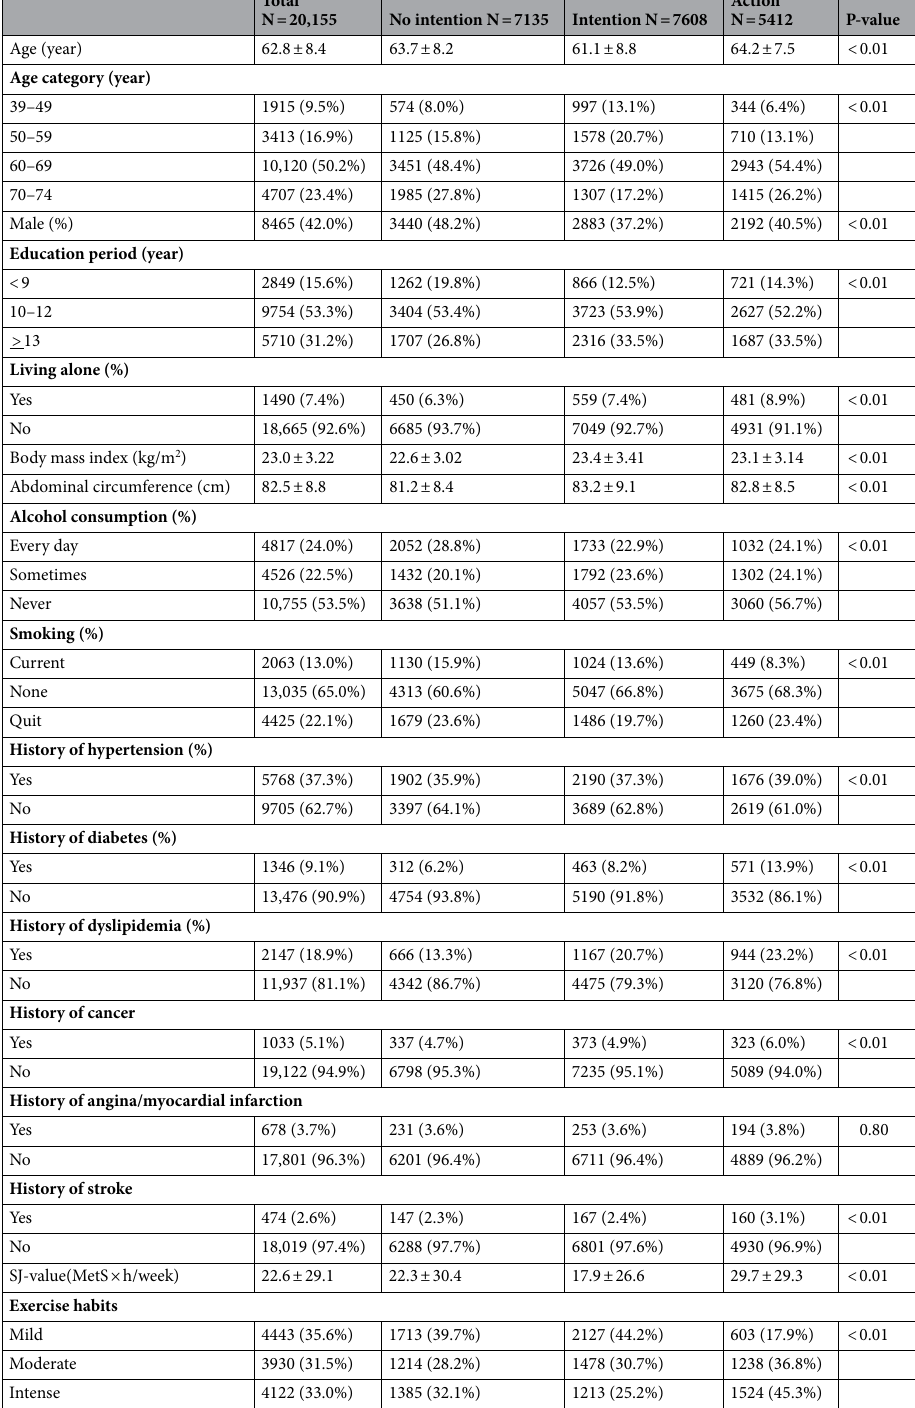
Table 1. Characteristics of study participants. Mean ± standard